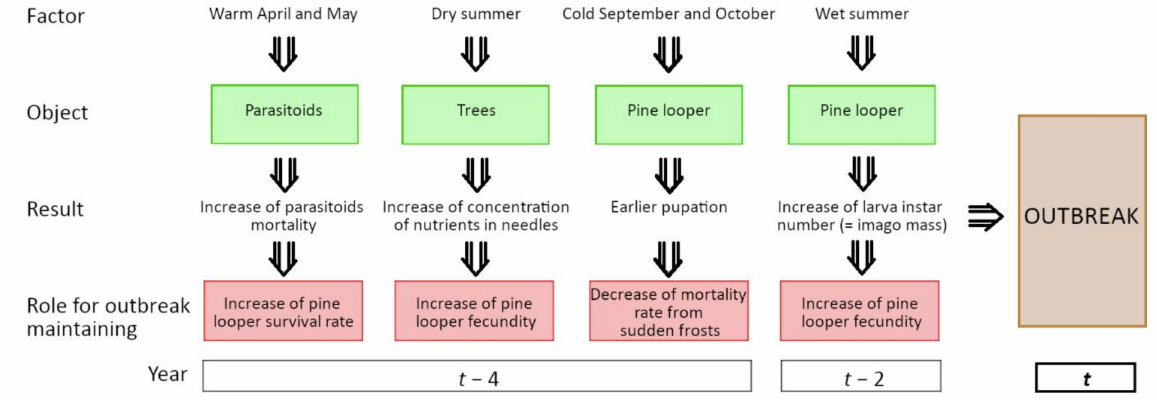
Figure 5. Principal scheme representing the occurrence of pine looper